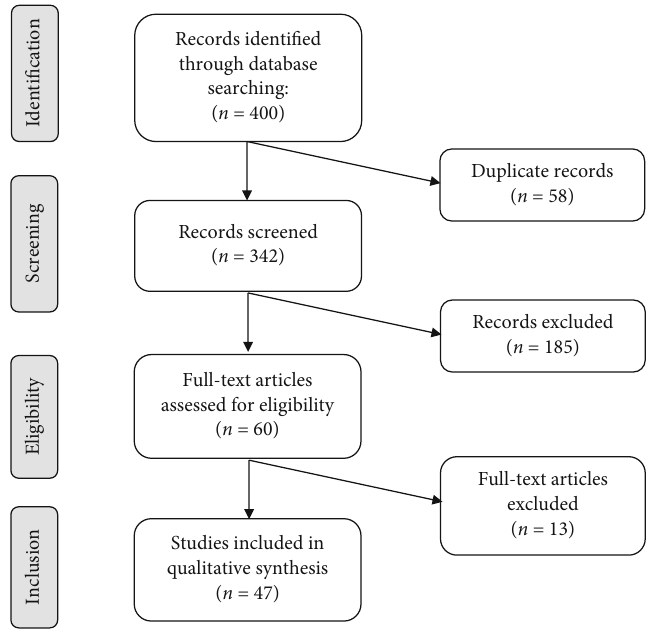
Figure 1: PRISMA fl ow diagram of the number of studies identi fi ed and included in the systematic